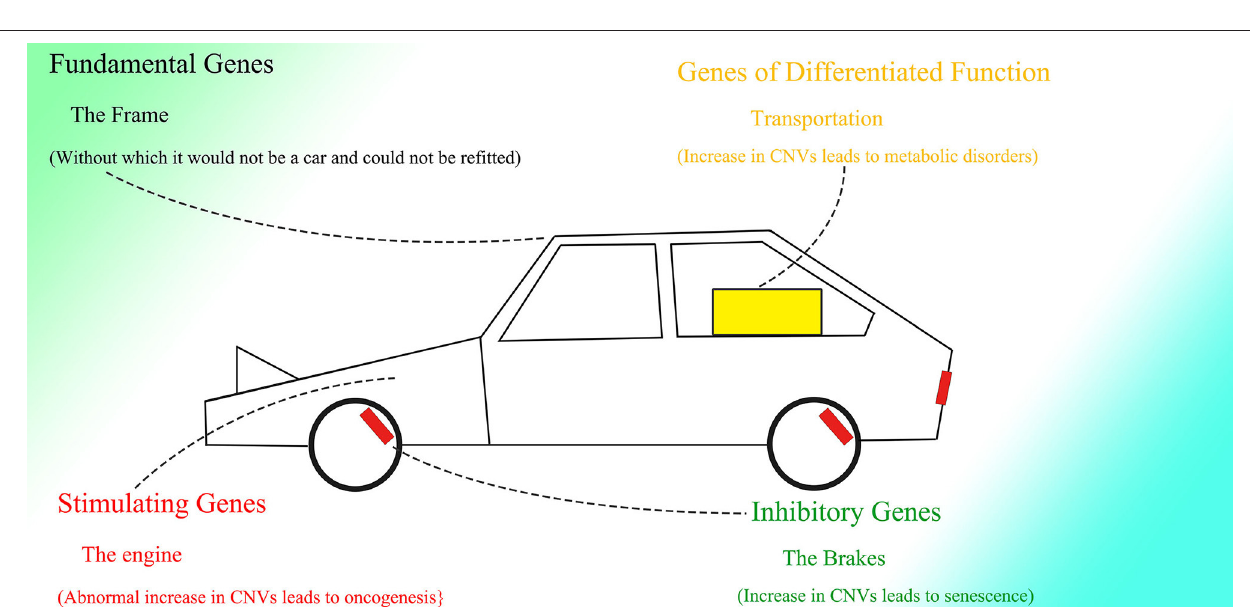
FIGURE 11 | A possible mechanism explaining expansion of the repeat sequence in HD and FXS affected by transcriptional level. As the abnormally expanded repeat is too long to jump across to produce a normal lariat, the 5 ′ end of the lariat could fall into the repeat sequence, which would ordinarily not happen. The repeat sequence could obscure recognition of the left foot of (cid:127) , making its complementary combination to the repeat downstream, which would create an insertion site that should not exist. This would lead to the insertion of the repeat sequence, and thus the repeat could be expanded.